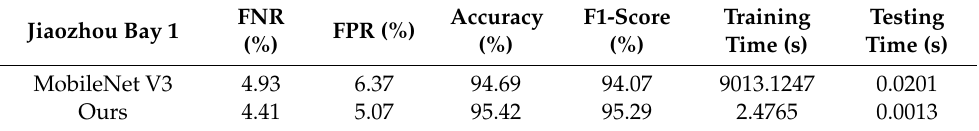
Table 3. Sand wave detection performance on Jiaozhou Bay 2.